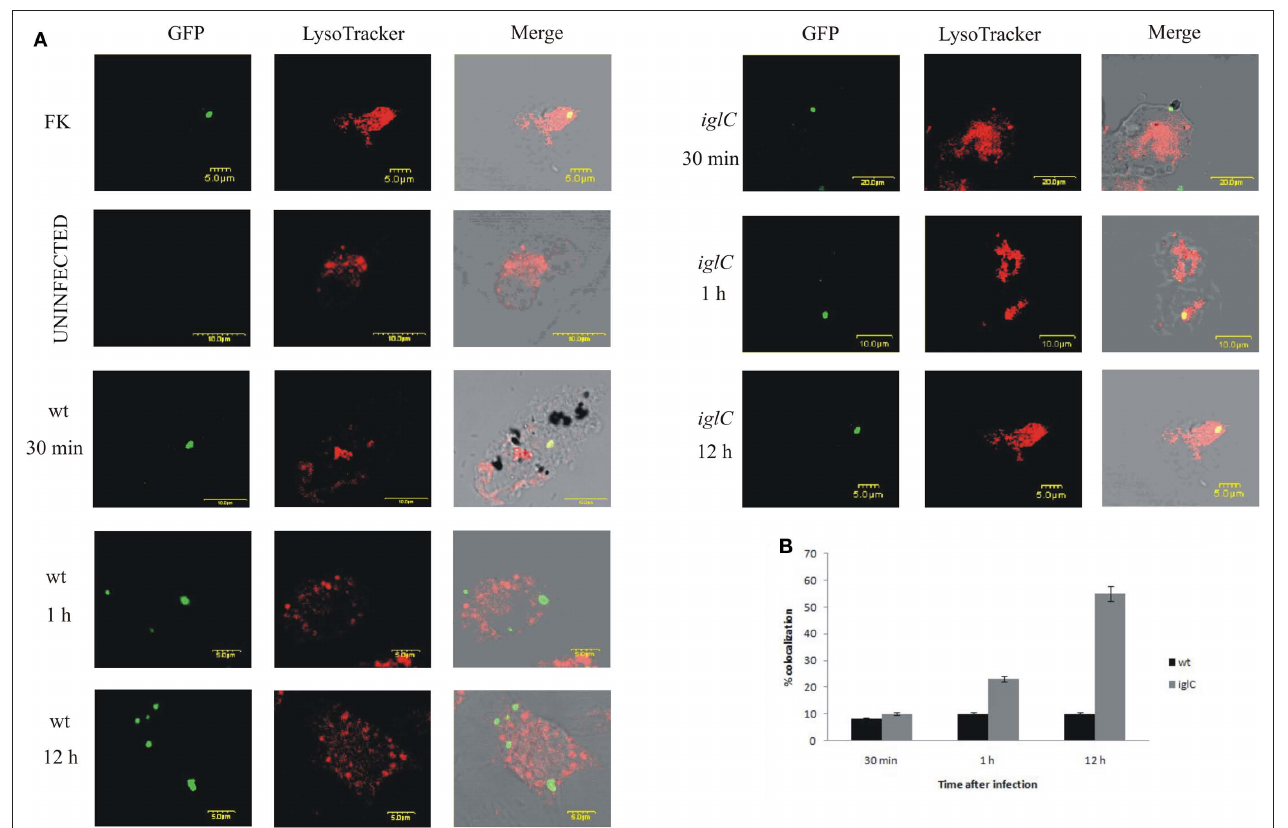
Figure 3 | Francisella novicida does not reside in acidic compartments within H. vermiformis cells. (A) Representative confocal microscopy images of colocalization of FCVs with the LysoTracker dye by the GFP-expressing wt F. novicida and iglC at 30 min, 1, and 12 h post-infection is shown. Uninfected cells were used as a negative control, while formalin killed bacteria served as a positive control. The images are representatives of 100 infected cells examined